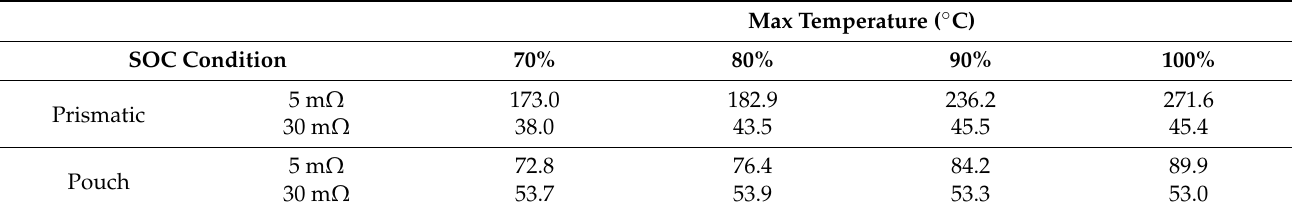
Table 4. Maximum temperatures during external short circuit.